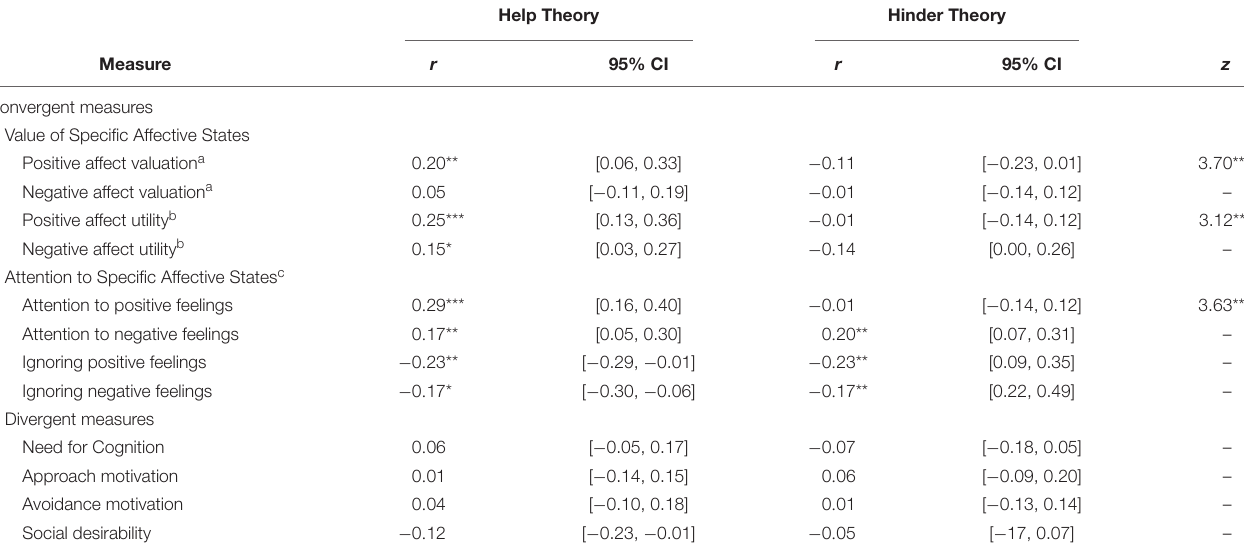
TABLE 2 | Study 1 correlations of HHTEM subscales with convergent and divergent measures and tests of the difference between dependent